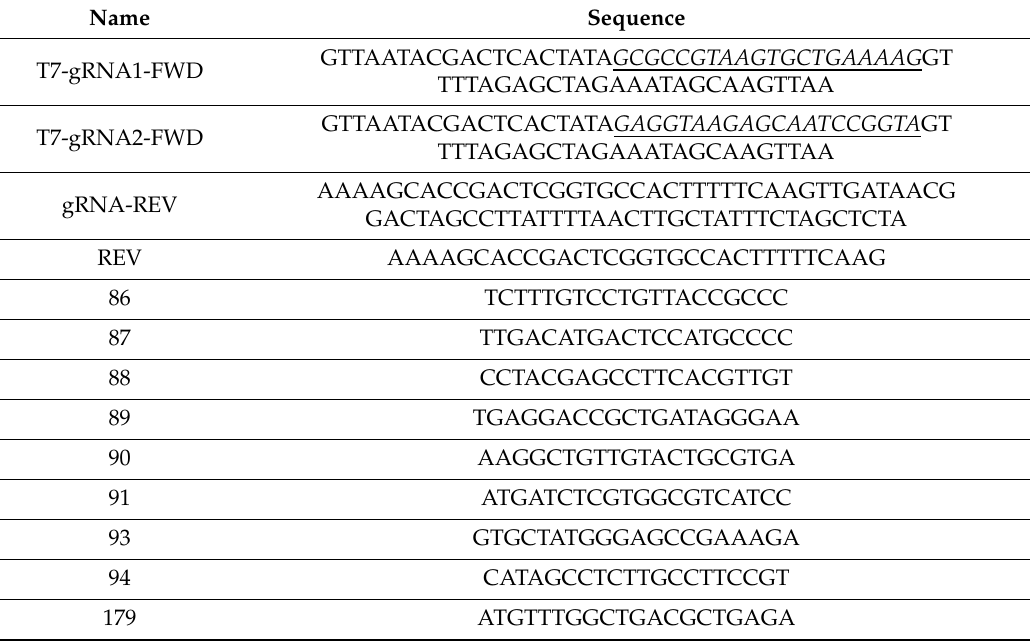
Table 1. DNA oligos for gRNA production and PCR